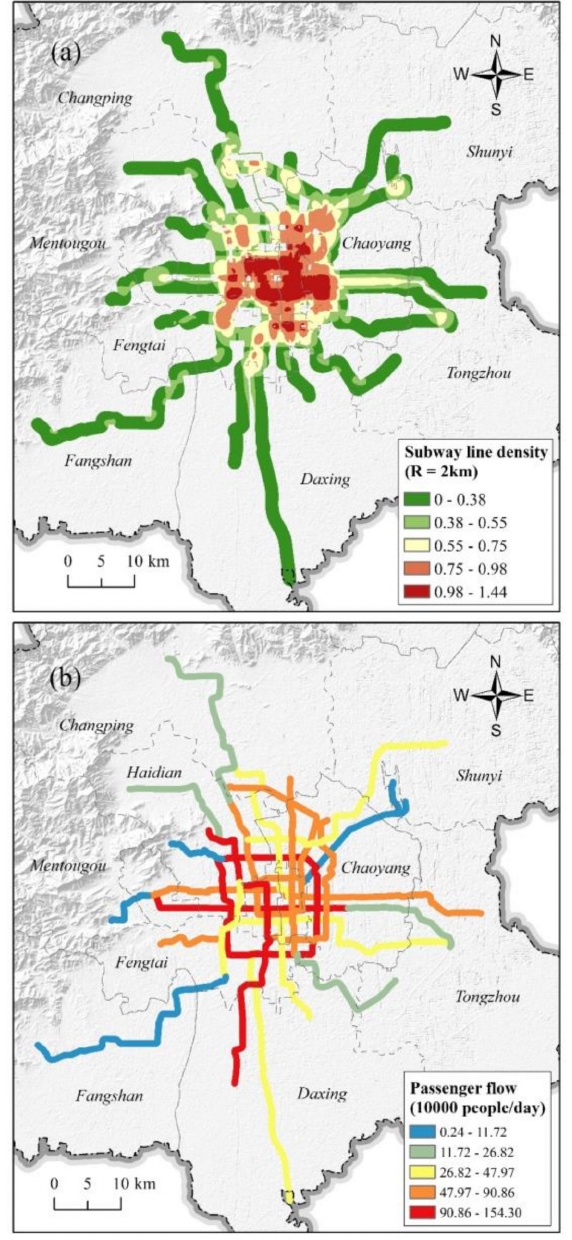
Figure 8. The subway line density (R = 2 km) ( a ) and daily passenger flow ( b ) of the Beijing subway